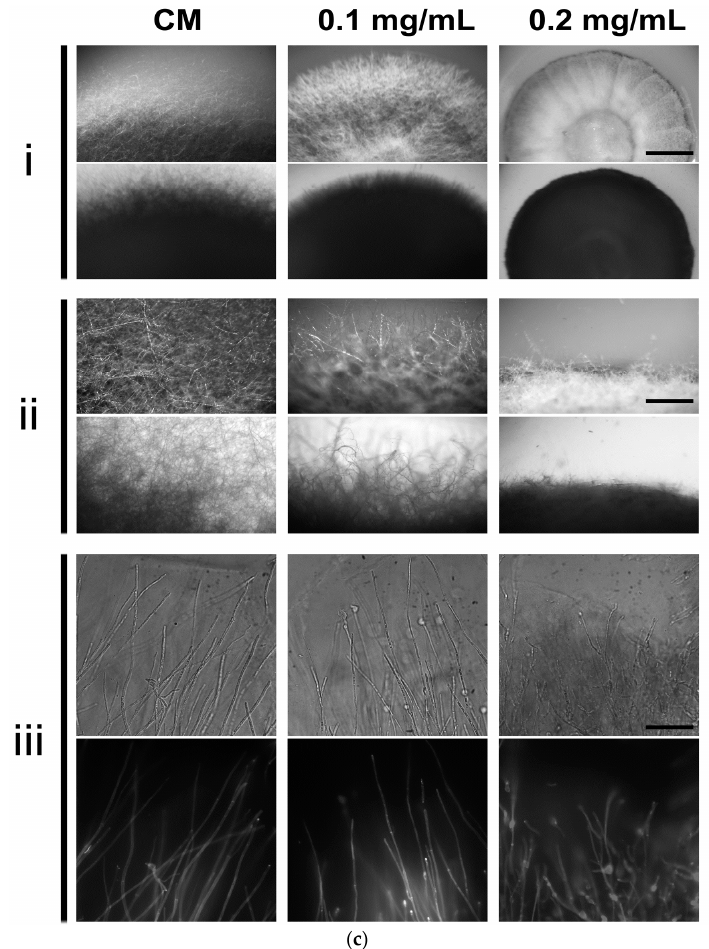
Figure 1. Inhibition test of equol on the mycelial growth of Magnaporthe oryzae . The M. oryzae strain Guy-11 was cultured on complete medium (CM), CM supplemented with equol or daidzein in gradient concentrations, or with 2% methanol on 6-cm culture plates at 28 °C for 6 days. ( a ) The colonial diameters were measured and the relative growths to that on CM were statistically compared. Error bars represent the deviation calculated from three replicates; ( b ) The images of the colonies on CM and CM with ( S )-equol; ( c ) The microscopic analysis of the mycelial growth upon ( S )-equol treatment. i and ii, the colonial edges were observed under a stereoscopic microscope with reflection light (the upper panels) and transmission light (the lower panels). iii, the mycelia at the colonial edges were stained with Calcofluor white and detected under a fluorescence microscope: the upper panel with a bright channel and the lower panel with a fluorescent channel. The bar in i represents 5 mm; in ii, 0.5 mm; and in iii, 5 μ m.